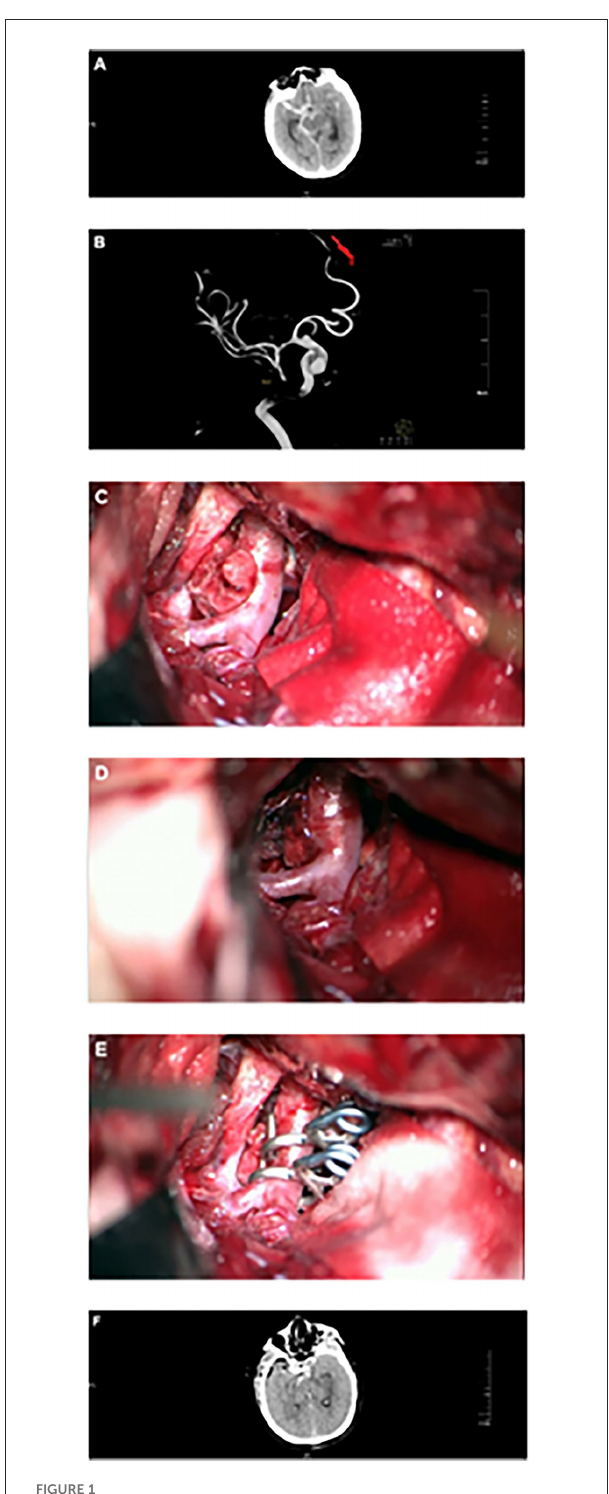
FIGURE1 Craniotomy microsurgery for a typical case. (A) Head CT showed subarachnoid hemorrhage. (B) DSA showed BBA at the right terminal internal carotid artery. (C) Intraoperative microscopy showed BBA, mural thrombus, or fibrous cap formation at the top of the tumor. (D) Intraoperative microscopy showed BBA, mural thrombus or fibrous cap formation at the top of the tumor with intravascular turbulence. (E) BBA was clipped with a transvascular clamp arrangement. (F) Head CT showed obvious brain swelling 2 days after the operation.